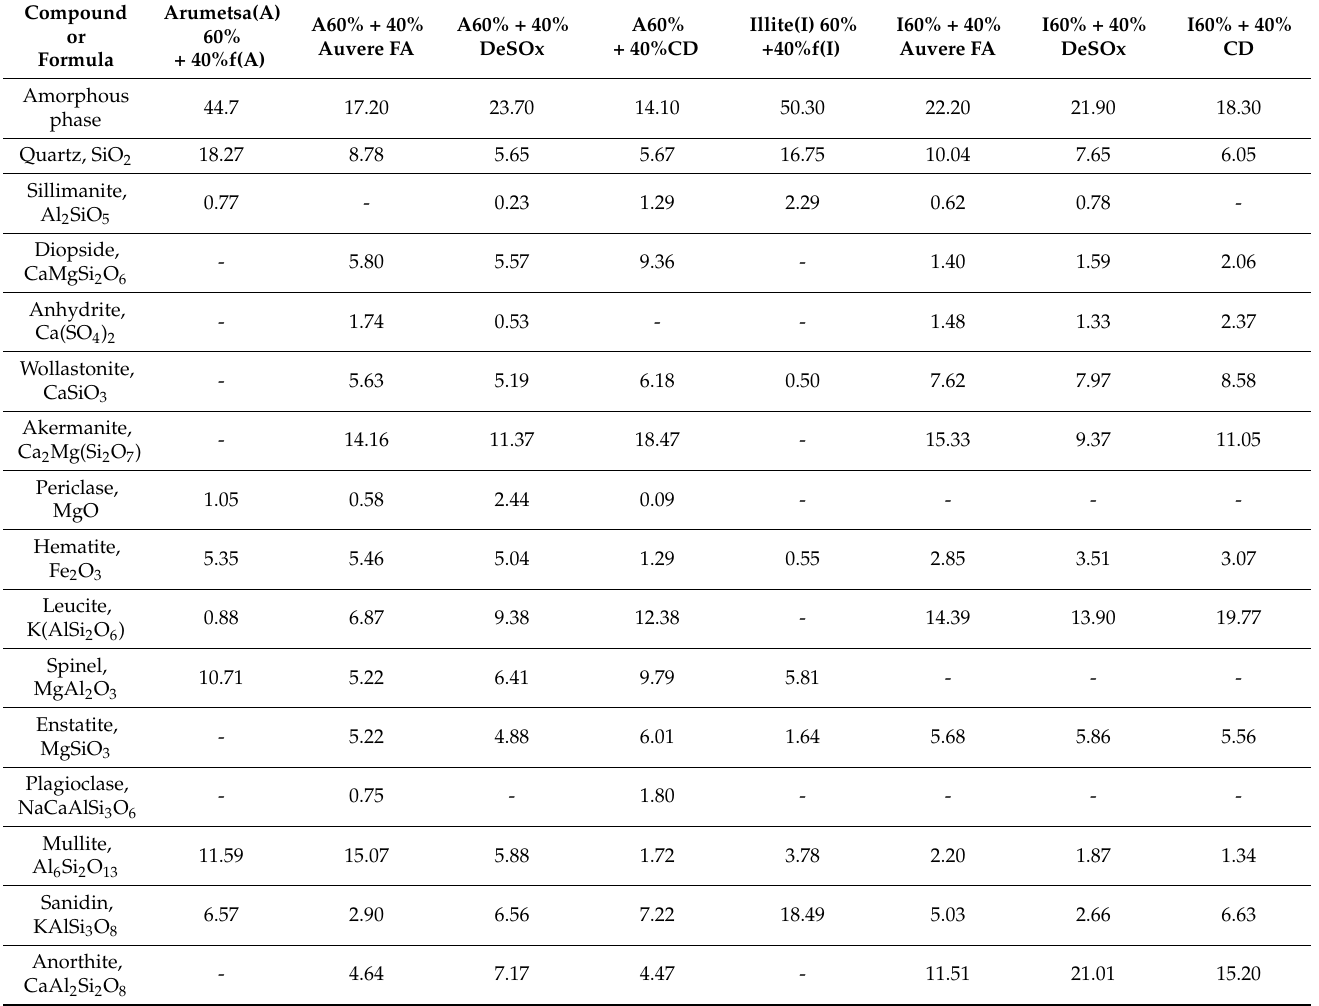
Table 3. Mineralogical composition (%) of thermally treated samples at 1050 ◦